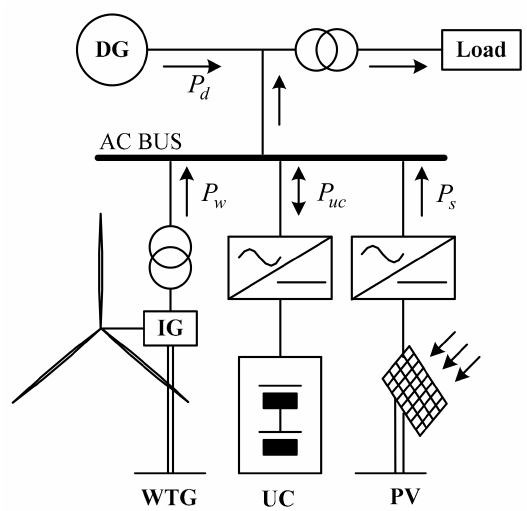
Figure 1. Micro-grid power system structure.